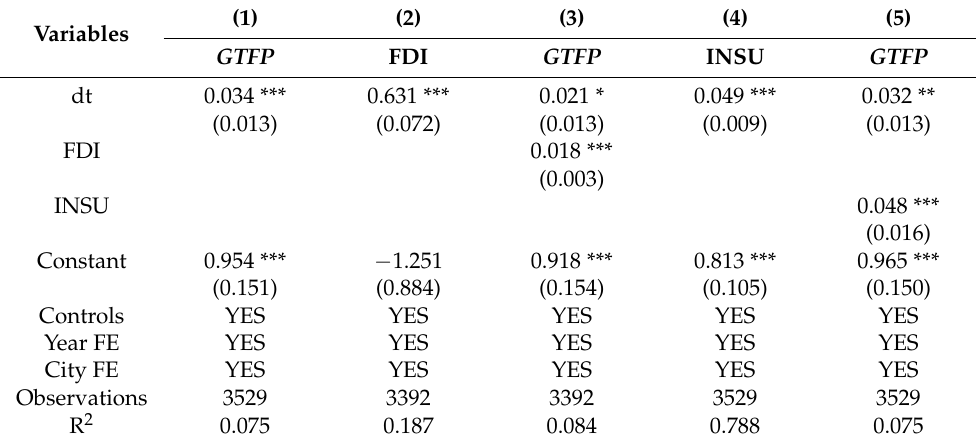
Table 8. Transmission mechanism of the FTZ policy affecting GTFP